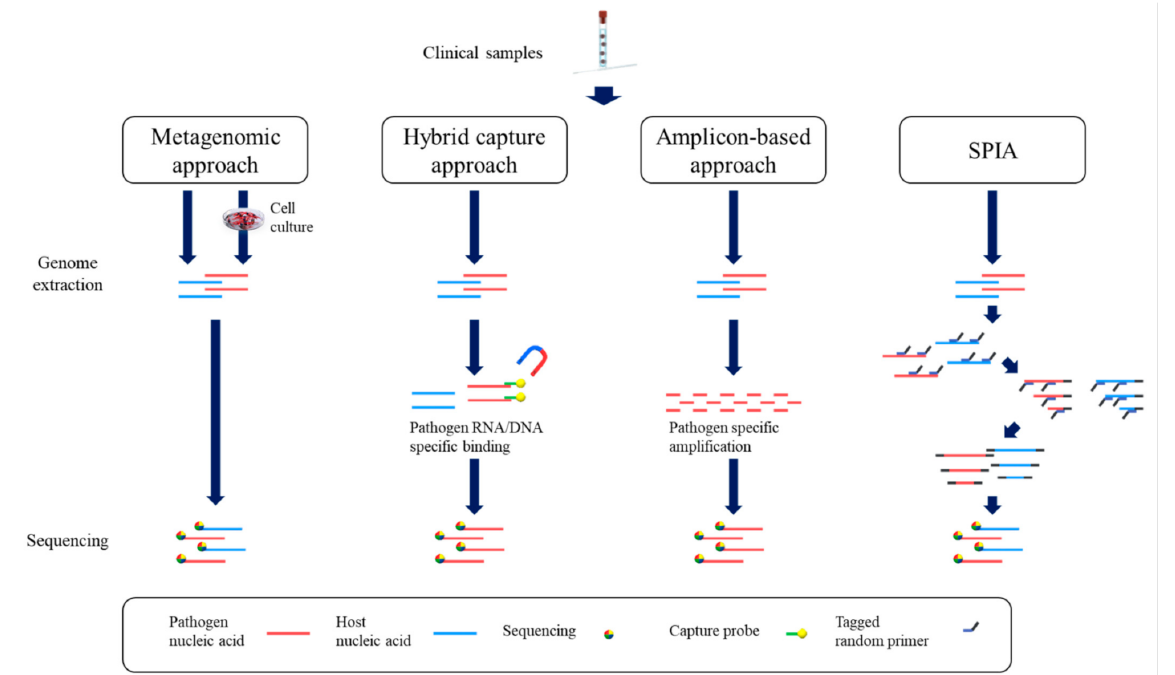
Figure 3. Schematic procedure of genome